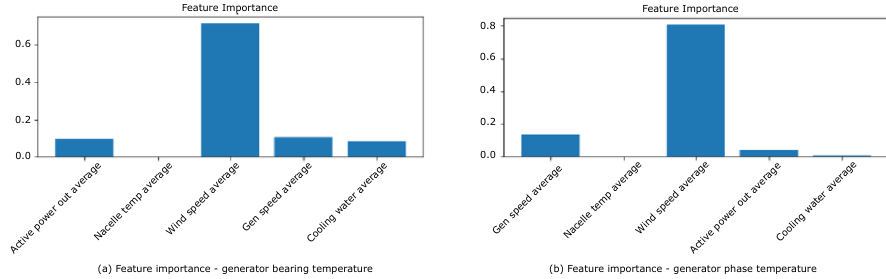
Figure 5. Overall feature importance of inputs and target using random forest impurity